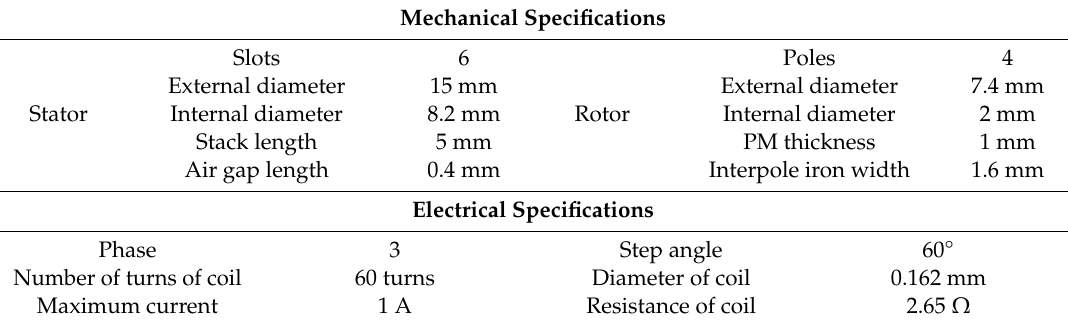
Table 1. Design specifications of the inset permanent magnet synchronous